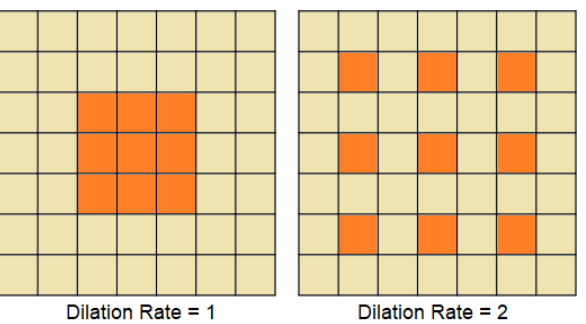
Figure 5. Sample example showing 3 × 3 convolution on 7 × 7 patch with dilation rates of 1 and 2 utilized in the proposed